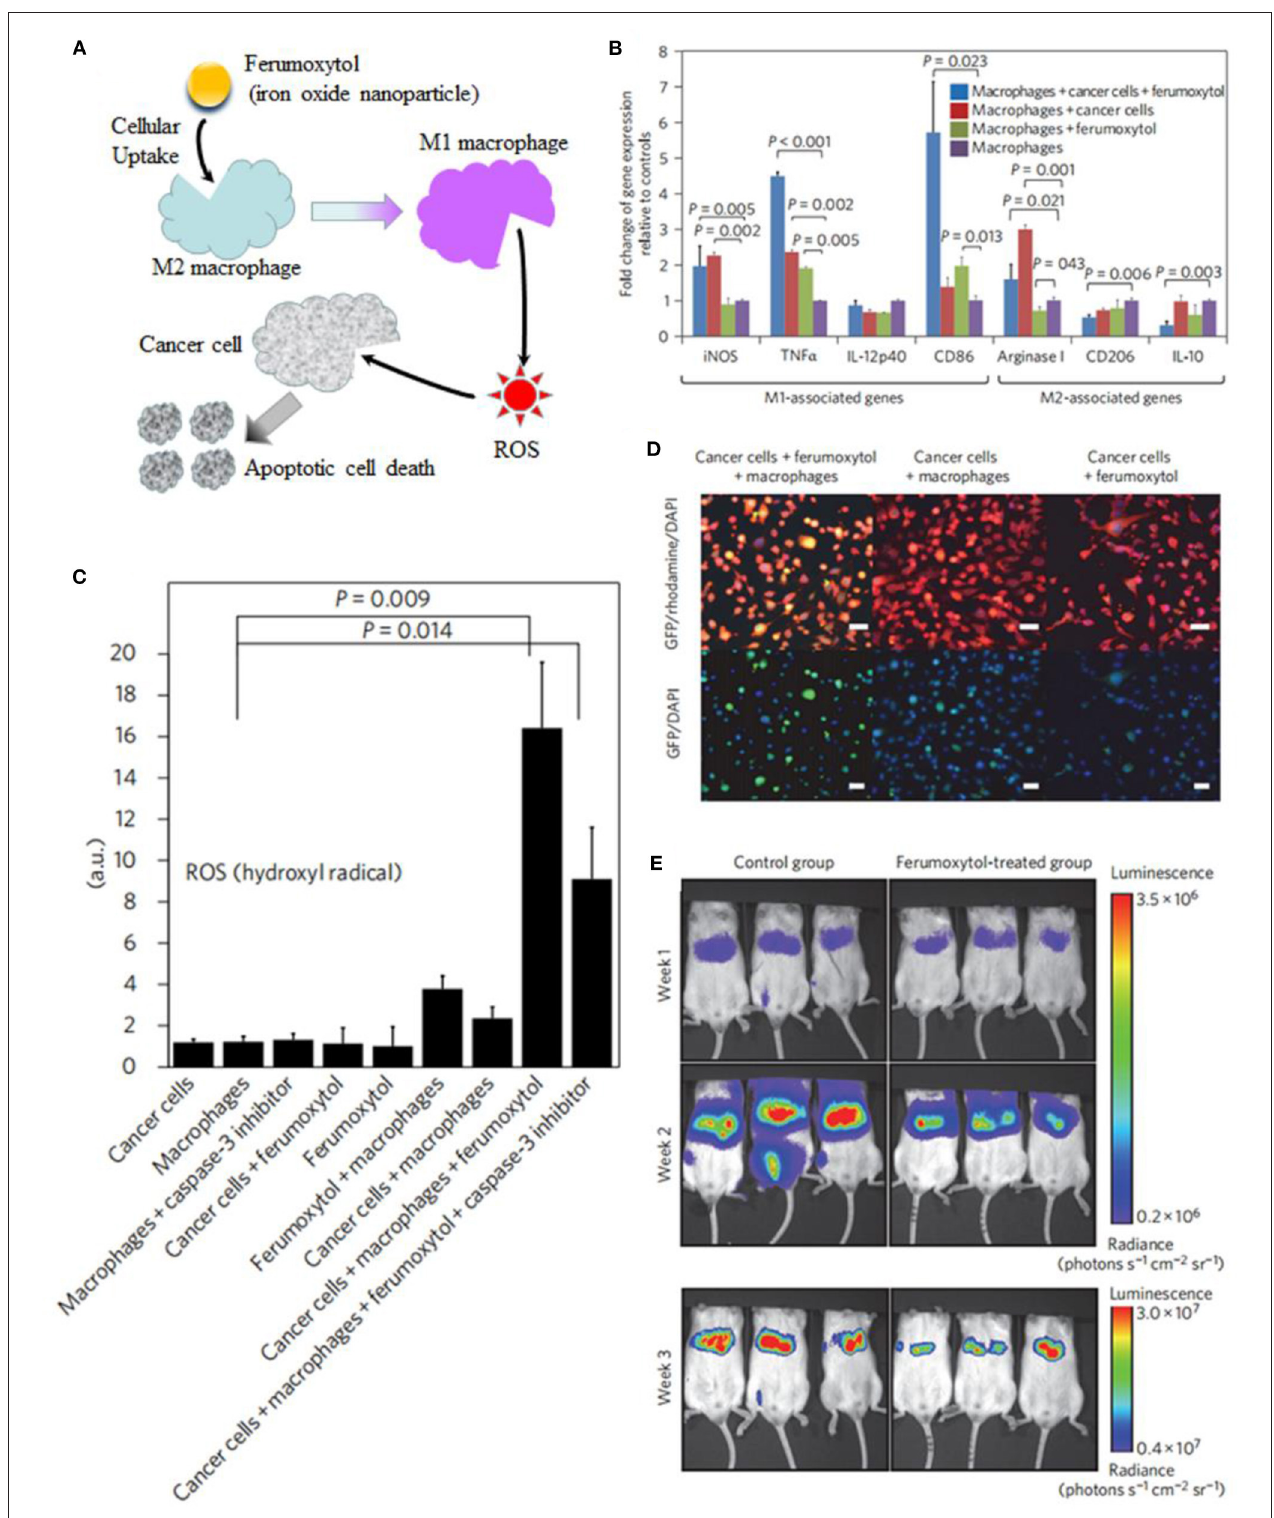
FIGURE 13 | (A) Schematic illustration of ferumoxytol-altered polarization of tumor-associated macrophages to release ROS, inducing cell death. (B) Signs of proinflammatory macrophage activation. (C) Quantitative measures of hydroxyl radical. (D) Coculture leads to increased caspase-3 expression of cancer cells. (E) Serial bioluminescence imaging after intravenous injection of ferumoxytol at a dose of 10mg Fe kg − 1 . Reproduced, with permission, from Tarangelo and Dixon (2016) and Zanganeh et al. (2016). Copyright 2016, Macmillan Publishers Limited.